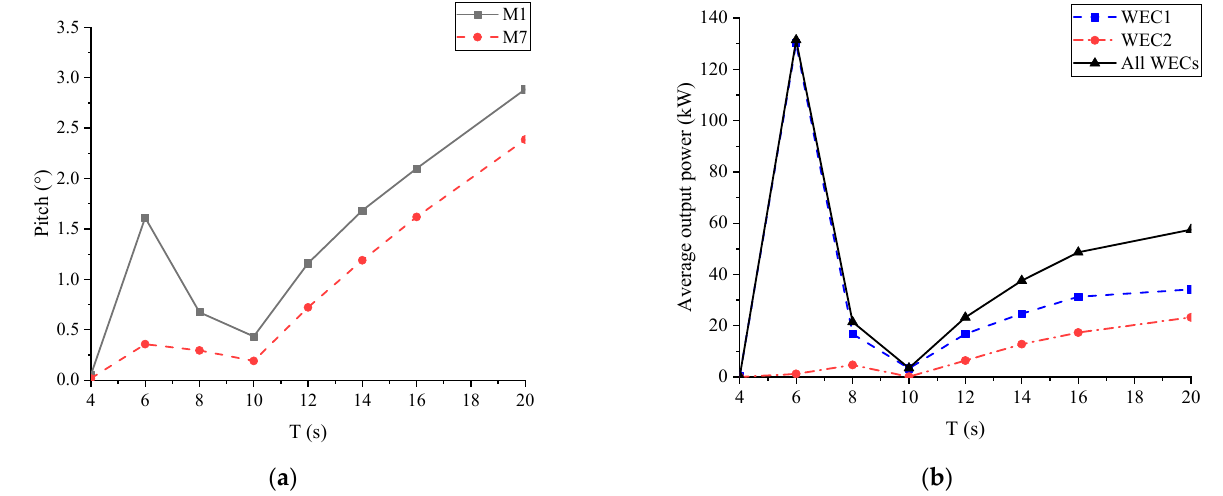
Figure 10. The WECs’ performance versus wave periods: ( a ) pitch; ( b ) average output power.